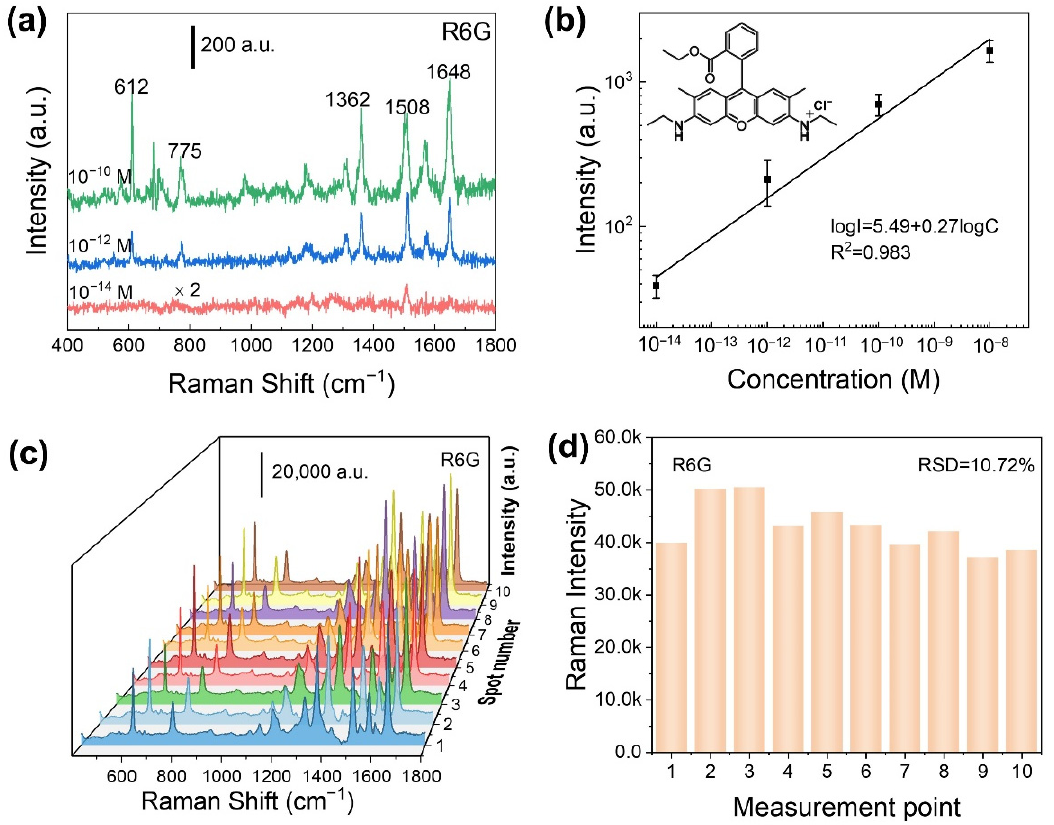
Figure 3. ( a ) SERS spectra of 10 − 10 , 10 − 12 and 10 − 14 M R6G collected from nanoporous Ag-decorated Ag 7 O 8 NO 3 micro-pyramids. ( b ) Linear relationship between the logarithmic intensities of 1648 cm − 1 peak and the concentrations of R6G. ( c ) SERS spectra of R6G (10 − 6 M) at 10 randomly selected sites on the SERS substrate made of nanoporous Ag-decorated Ag 7 O 8 NO 3 micro-pyramids. ( d ) The 1648 cm − 1 band intensities of R6G (10 − 6 M) recorded from 10 randomly selected sites. As a significant parameter for quantitatively comparing SERS performance, the en- hancement factor (EF) of the nanoporous Ag-decorated Ag 7 O 8 NO 3 micro-pyramids was determined by computing the ratio of SERS to normal Raman scattering (NRS) of R6G (Figure S10) using the following